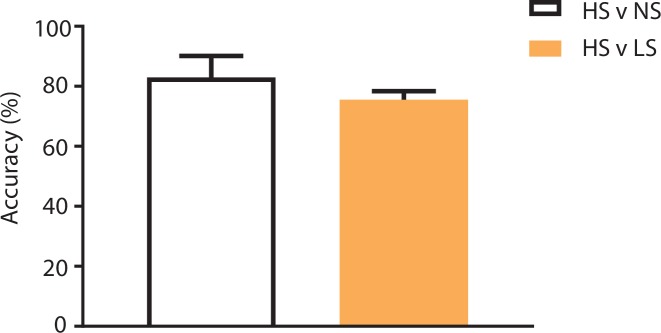
Population-decoding analysis using a shorter 3 s time window.SVM analysis using a shorter 3 s time window to distinguish between HS and NS (83%) or HS and LS (76%) yielded similar results to analysis using a longer 5 s time window (Figure 2F). n = 9.